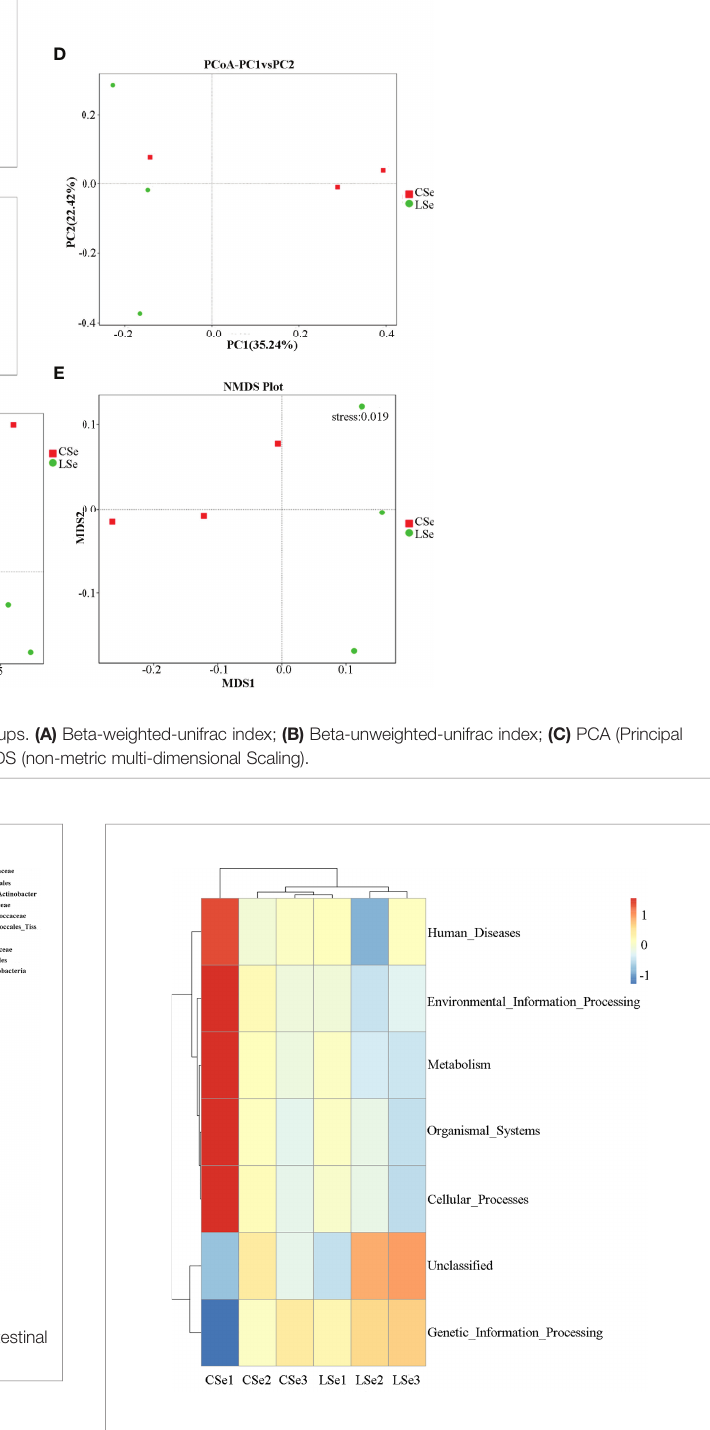
FIGURE 8 | Tax4Fun function predictive analysis. According to the functional notes and abundance information of samples in the database, the top 35 functions and their abundance information in each sample were selected to draw a heat map. And cluster from the level of functional difference. The abscissa is the sample name and the ordinate is the feature